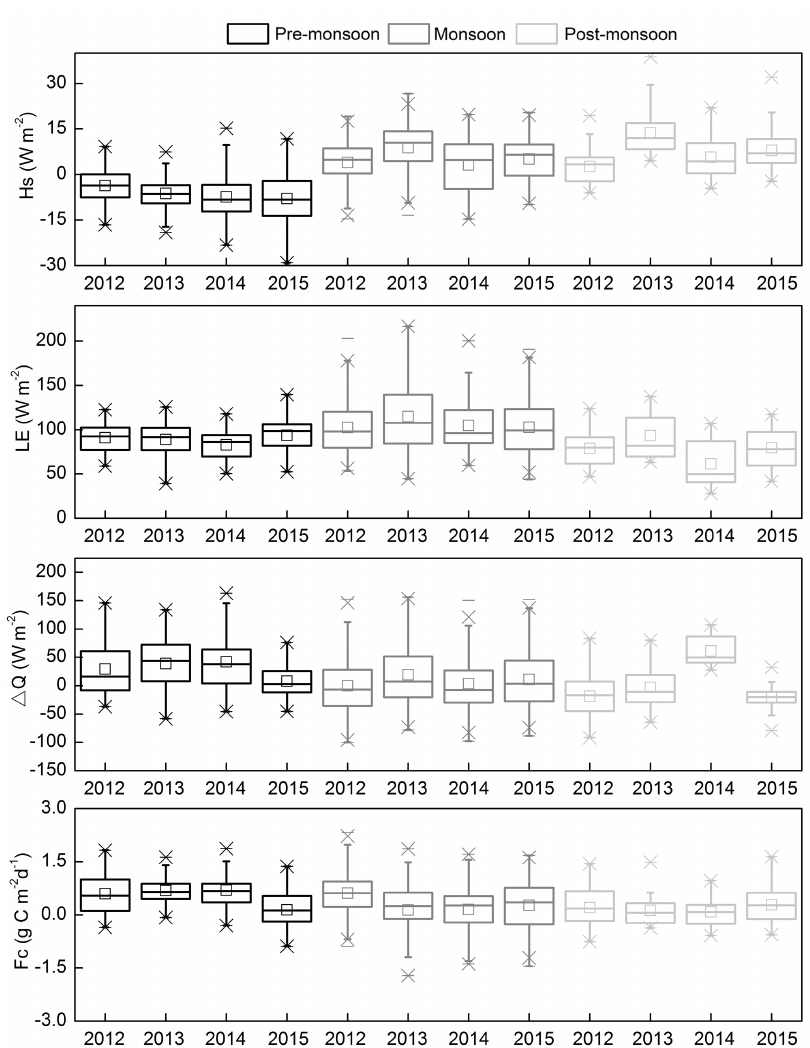
Figure 9. Box plot of daily average sensible heat flux ( H s ), latent heat flux (LE), the storage heat flux in the lake ( (cid:49)Q ) and CO 2 flux ( F c ) during pre-monsoon, monsoon and post-monsoon periods from 2012 to 2015. The upper and lower limits of the box represent the 75 and 25 percentiles; the horizontal line in each box represent the 1.5 inter-quartile range of the upper and lower quartile; the band inside the box is the median; the squares inside the box represent the average value; the cross-hatches represent the 1 and 99 percentiles; the end whiskers represent maximum and minimum